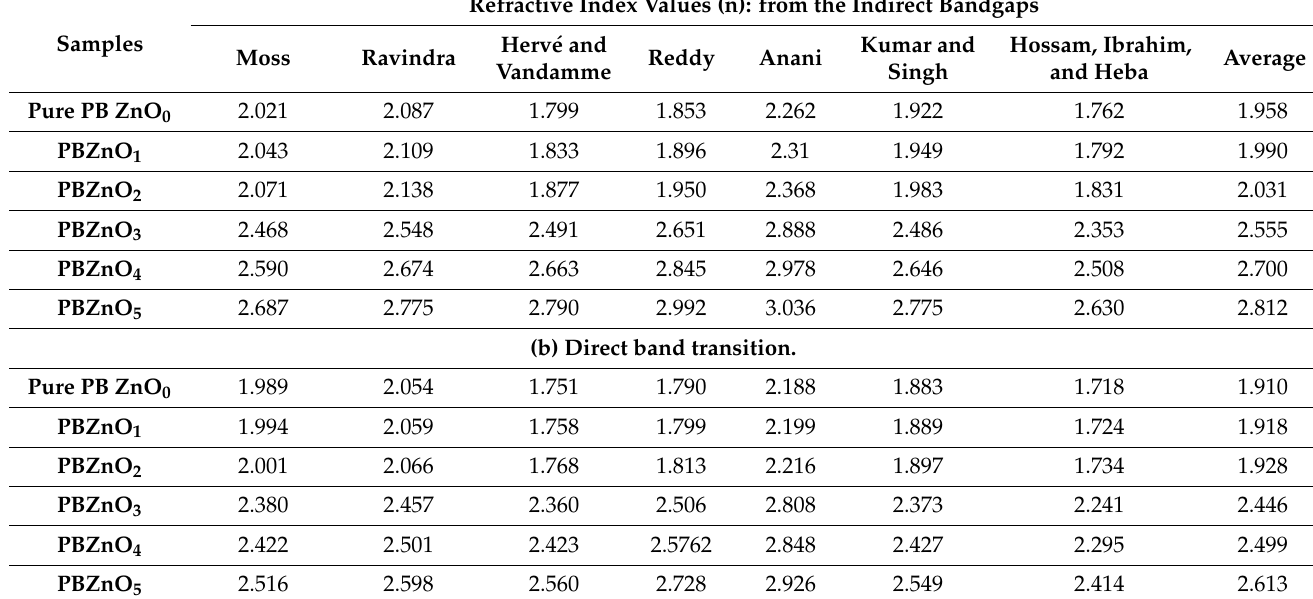
Table 3. Calculated refractive index from Moss, Ravindra, Herv é , Reddy, Anani, Kumar- Singh, and Hossam relations and the average refractive index value for the investigated polymeric films with various adding nanofiller. (a) Indirect Band